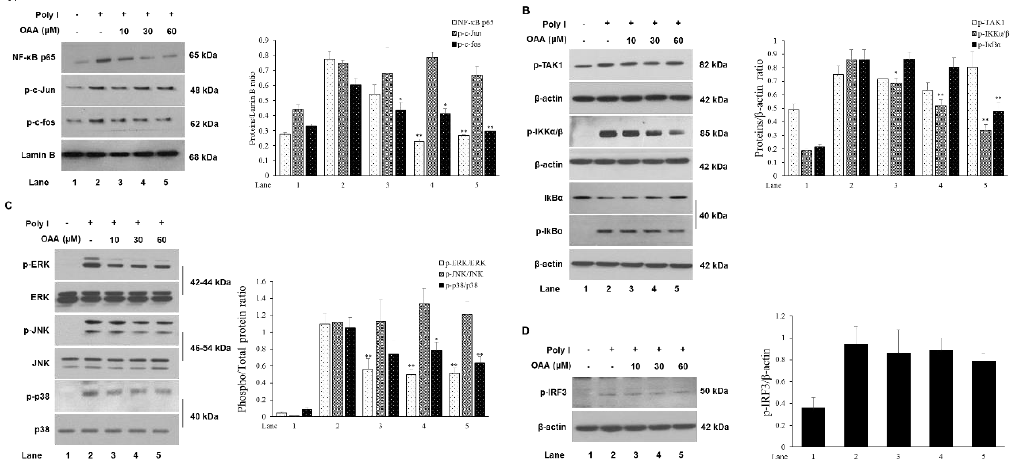
Figure 3. OAA downregulates poly(I)-induced TLR3 signaling. Cells were pretreated with the indicated concentrations of OAA for 1 h and then stimulated with poly(I) (50 µ g / mL) for 30 min to 3 h. Cell lysates were prepared for Western blotting analysis with the indicated antibodies. OAA inhibits the poly(I)-induced nuclear translocation of NF- κ B and c-fos ( A ), and phosphorylation of IKK α / β , I κ B ( B ), ERK, and p38 ( C ) and IRF3 ( D ). Values are presented as ± SD of three individual experiments. * p < 0.05 and ** p < 0.01 compared with the Poly I-treated group.